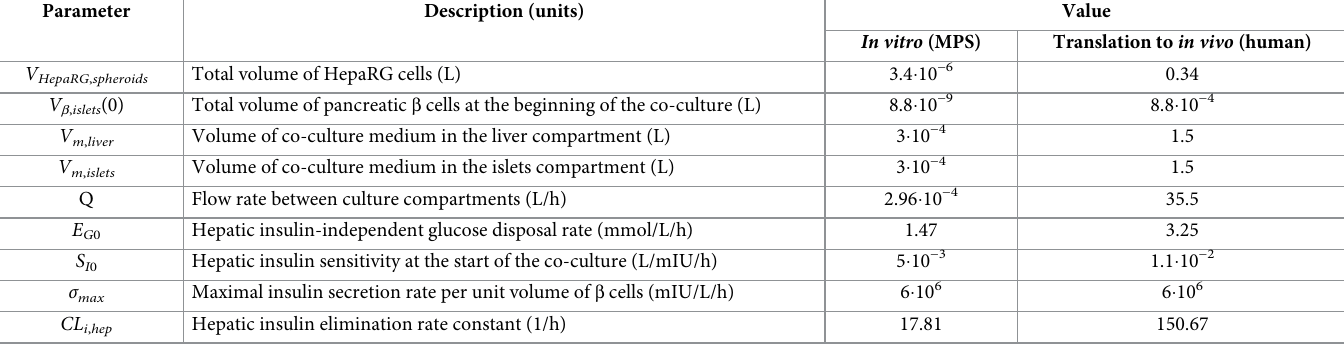
Table 2. Extrapolation of parameter values in the computational model to perform in vitro to in vivo translation. The results correspond to experiment 1. Parameter Description (units) Value In vitro (MPS) Translation to in vivo (human) V HepaRG , spheroids Total volume of HepaRG cells (L) Total volume of pancreatic β cells at the beginning of the co-culture (L) Volume of co-culture medium in the liver compartment